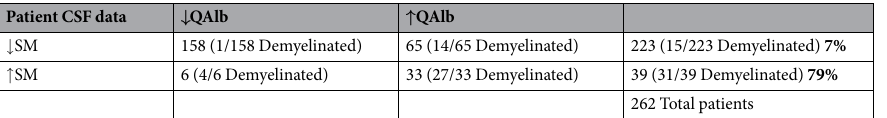
Table 1. Patients distribution according to SM values. ↓ SM = CSF Sphingomyelin under the cut-off; ↑ SM = CSF Sphingomyelin over the cut-off; ↓ QAlb = CSF QAlb index under the cut-off; ↑ QAlb = CSF QAlb index over the